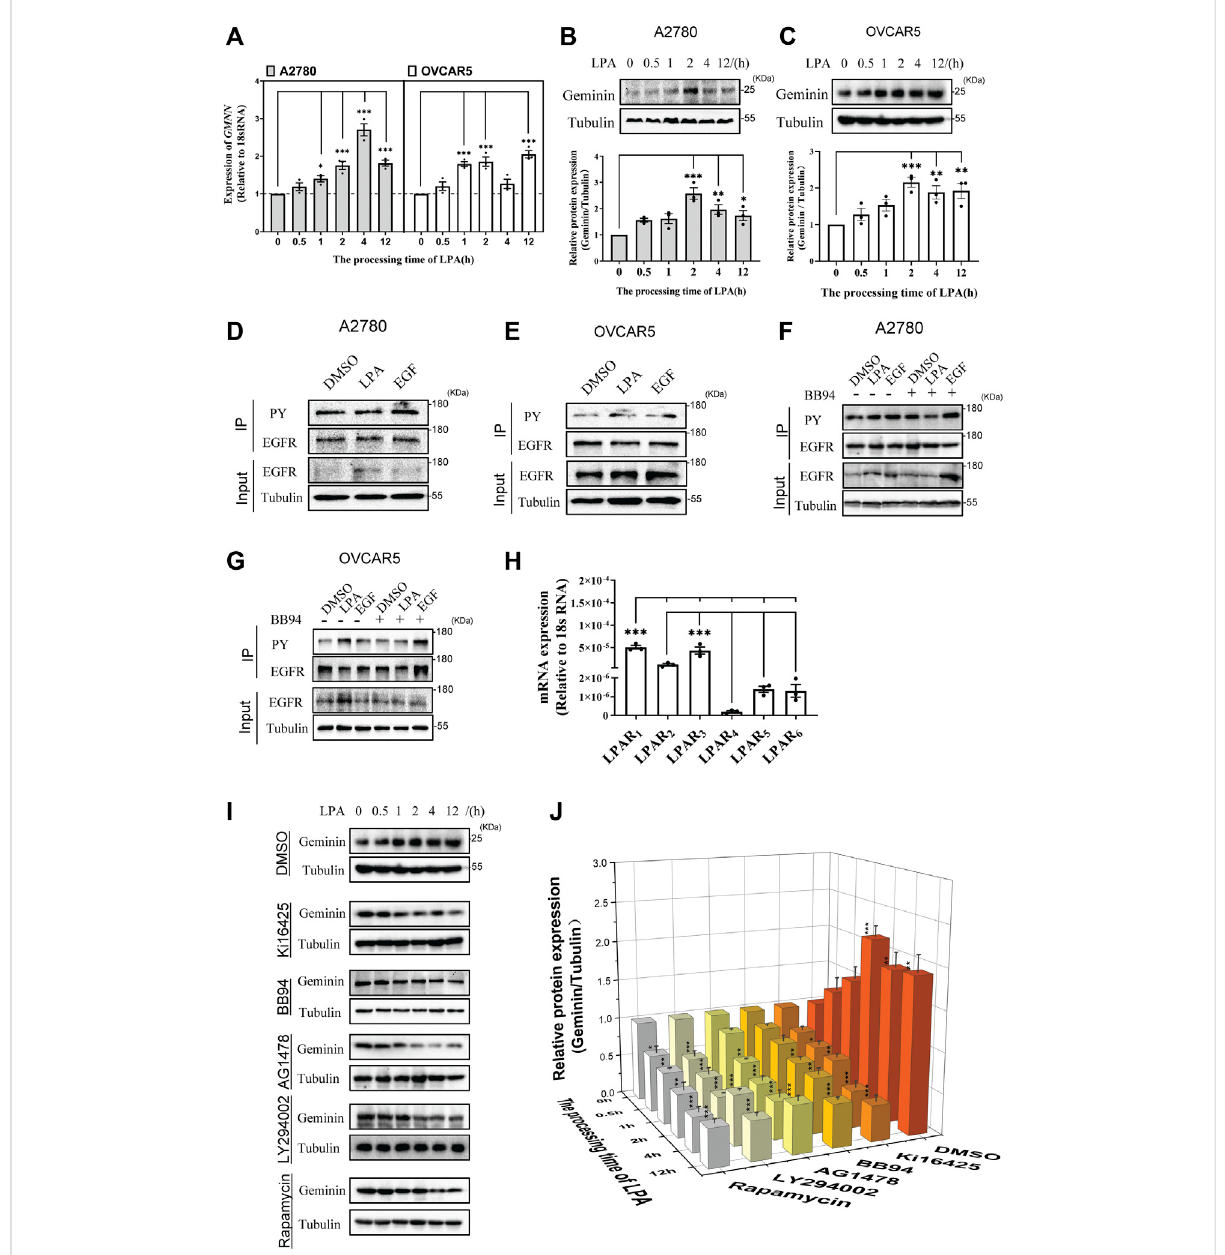
FIGURE 2 LPA enhances geminin expression via a LPAR 1/3 /MMPs/EGFR/PI3K/mTOR signalling pathway in HGSOC cells. (A) The mRNA expression levels of geminin in A2780 cells and OVCAR5 cells. VNOVA, Dunnett ’ s Multiple Comparison Test, mean ± SEM, n = 3, * p < 0.05, *** p < 0.001. (B,C) Immunoblotting analysis of geminin protein levels in A2780 cells (B) and OVCAR5 cells (C) under a 10 μ M LPA time gradient stimulus. Quanti fi cation of three independent experiments was performed, normalized to tubulin, and expressed as a ratio of 0 h, respectively. Mean ± SEM, VNOVA, Dunnett ’ s Multiple Comparison Test, * p < 0.05, ** p < 0.01, *** p < 0.001. (D,E) Immunoprecipitation analysis with tyrosine-phosphorylated EGFR antibodies(PY)inA2780cells (D) andOVCAR5cells (E) treatedwith0.1%DMSO(vehicle),10 μ MLPAor10 ng/mLEGFfor5 min. (F,G) IPanalysis with tyrosine-phosphorylated EGFR antibodies (PY) in A2780 cells (F) and OVCAR5 cells (G) pretreated with or without 10 μ M BB94 for 30 min, and then stimulatedwith0.1%DMSO(vehicle), 10 μ MLPAor10 ng/mLEGFfor5 min. (H) ThemRNAexpressionofLPARsinOVCAR5cells.Mean±SEM, n =3, VNOVA,Dunnett ’ sMultipleComparisonTest,*** p < 0.001. (I) IBanalysisofgemininproteinlevelsinOVCAR5cellsasindicated.Cellswerepretreated with0.1%DMSO(vehicle),10 μ MKi16425,10 μ MBB94,10 μ MAG1478,10 μ MLY294002or100 nMRapamycinfor30